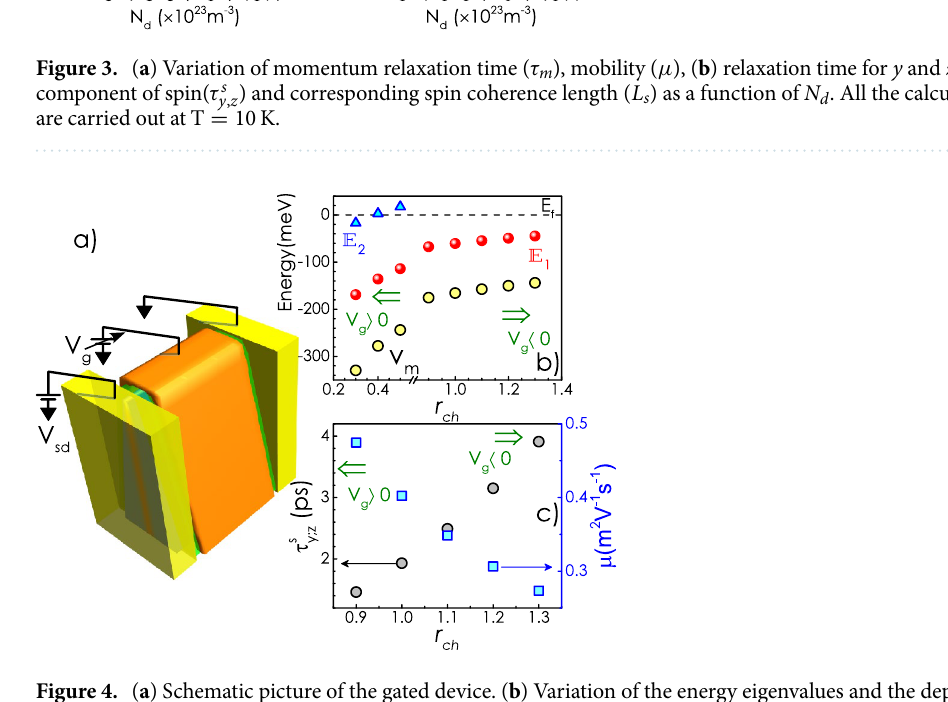
Figure 4. ( a ) Schematic picture of the gated device. ( b ) Variation of the energy eigenvalues and the depth of the potential well with r ch . ( c ) Electron mobility ( µ ) and τ s y , z as a function of r ch . All the calculations are carried out at T = 10